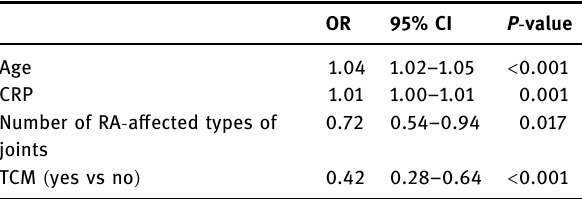
Table 4: Ordinal logistic regression analysis of the number of